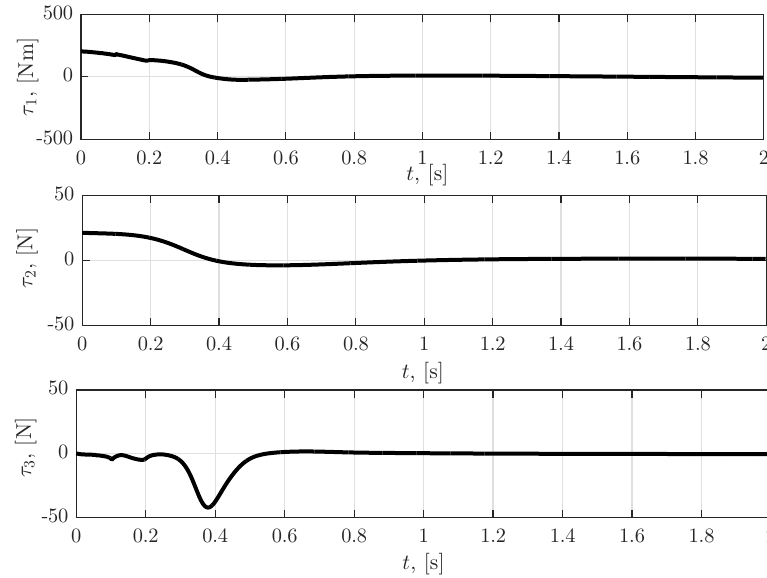
Figure 6. Time dependence of the force and torque applied to the robot links.